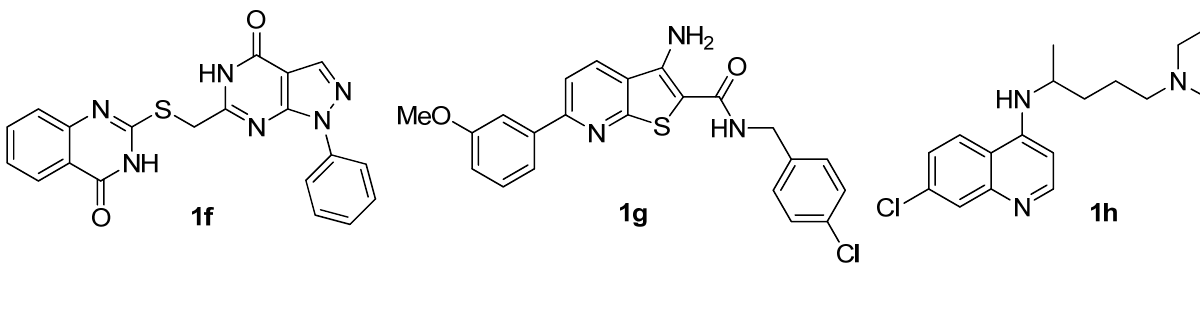
Figure 2. The representive hit compounds 1f , 1g and 1h in our screening of anticancer